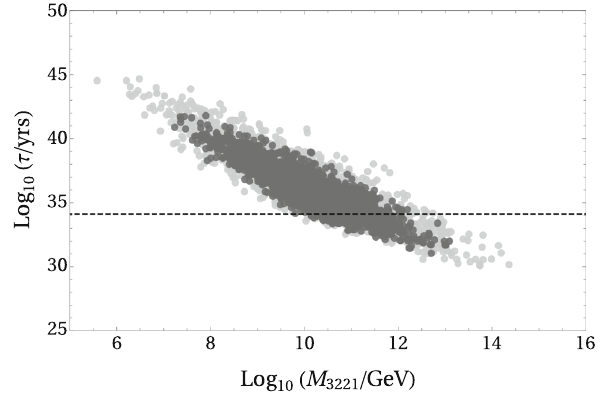
Fig. 10 Impact of possible thresholdcorrections onthe proton lifetime × SU ( 2 ) × U ( 1 ) τ in SO ( 10 ) models with intermediate SU ( 3 ) C L R U ( 1 ) X symmetry. The gray dots denote randomized mass spectra with , 2 ] . The , 2 ] while the light gray dots denote spectra with R ∈ [ 1 R ∈ [ 1 20 10 The dashed line denotes the present bound from Super-Kamiokande